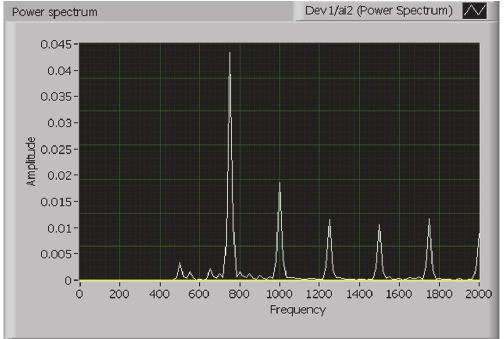
Figure 12: FFT of the radar output for a metallic panel 1.4m far from the radar